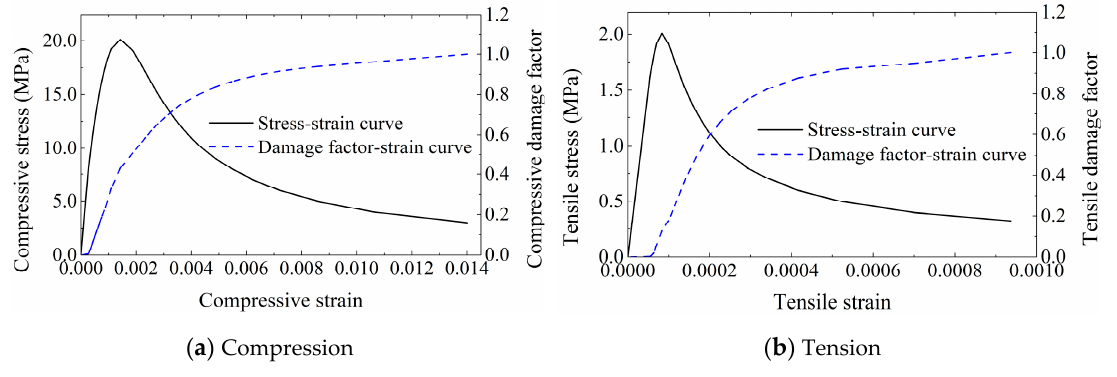
Figure 7. Stress–strain curve and damage factor–strain curve of C30 concrete. Table 3. Physical and mechanical parameters of the concrete.